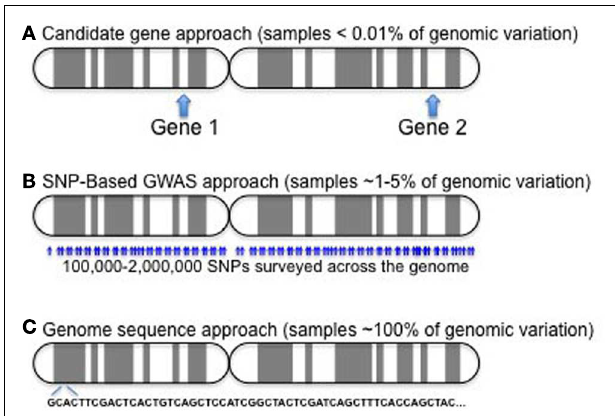
FIGURE 2 | Candidate gene approaches (A) have only involved a few variants in one to several dozen genes. Given a genome of roughly 25,000 genes, this represents a very small sampling ( ∼ 0.01% or less). GWAS (B) samples a much larger component of the genome, probing more than 90% of the genes, but it still only examines less than 5% of the over 50 million reference SNPs (http://www.ncbi.nlm.nih.gov/mailman/ pipermail/dbsnp-announce/2012q2/000123.html) curated as of June, 2012. As costs come down, exome (not shown) and whole-genome sequencing (C) provide the potential to capture all variation in study